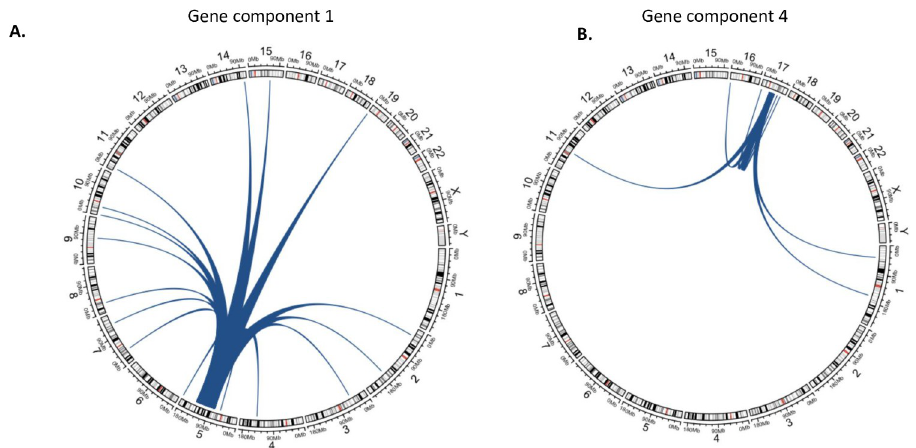
Fig 2. Examples of trans -associations identified in using the genes selected through sCCA in (A) Gene component 1 (B) Gene component 4. Several genes in a chromosome different from that of the selected CNA is identified. Further, numerous distal genes ( > 10Mb) on the same chromosome are detected as